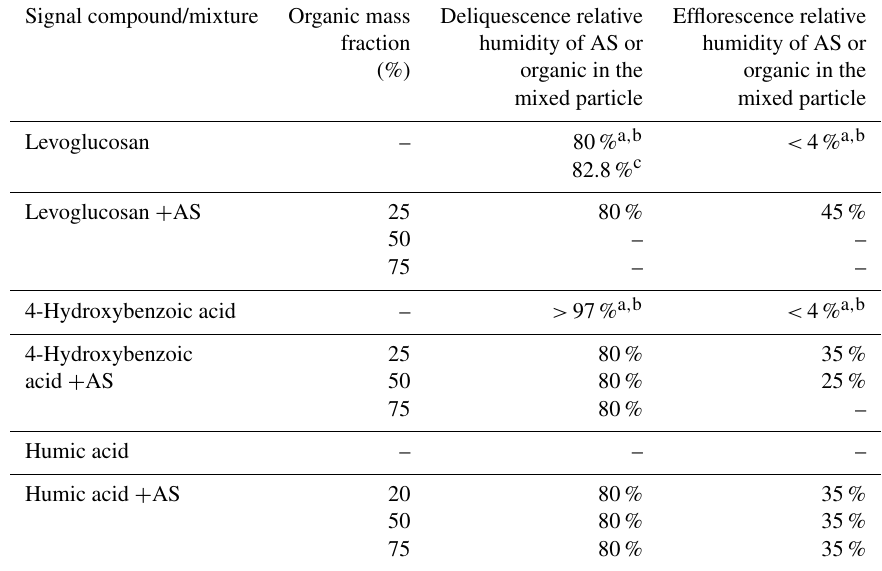
Table 4. Experimental studies of organic and ammonium sulfate (AS) deliquescence and efflorescence RH from this work and previous studies at